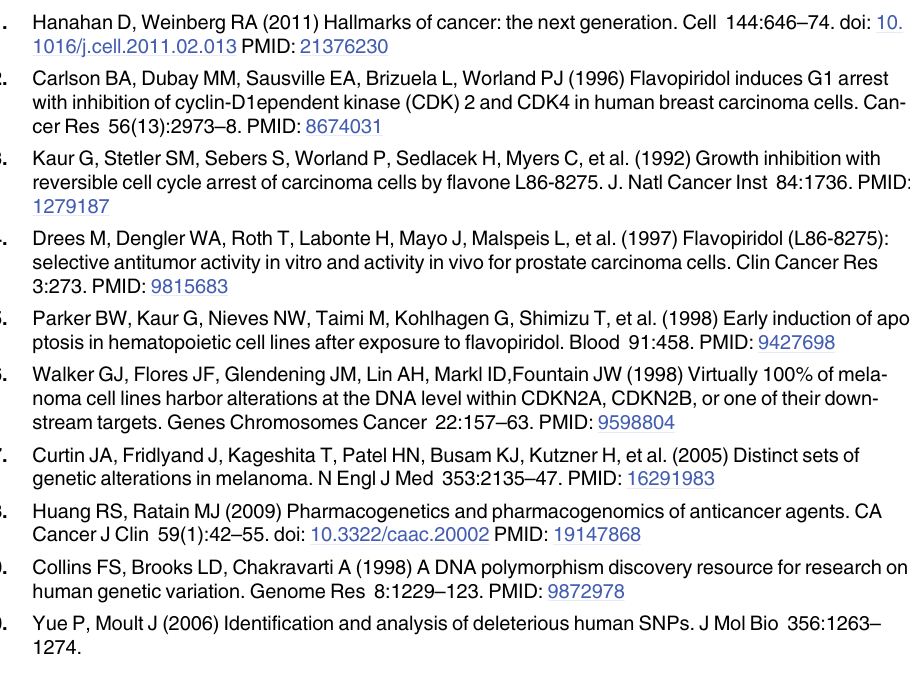
S4 Fig. Solvent accessible surface area (SASA) analysis of native and mutant CDK4-cyclin D1 complexes. Black, Red, Green, Blue, Orange and pink lines indicate native, R24C, Y180H, (TIF) S5 Fig. Projection of the motion of proteins in phase space along the first two principal eigenvectors. Black, Red, Green, Blue, Orange and pink lines indicate native, R24C, Y180H, A205T, R210P, and R246C CDK4-Cyclin D1 protein complexes. (TIF) S6 Fig. Backbone Root Mean Square Deviation (RMSD) of CDK4 protein in complex with selective inhibitors. The ordinate is RMSD (nm), and the abscissa is the time (ps). Black, Red, Green, Blue, Orange and Pink lines indicate native, R24C, Y180H, A205T, R210P, and R246C protein-ligand complexes respectively.